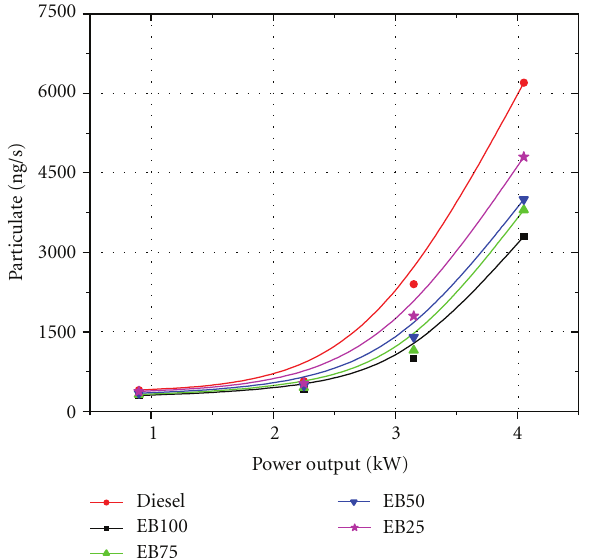
Figure 10: Particulates emissions at various power